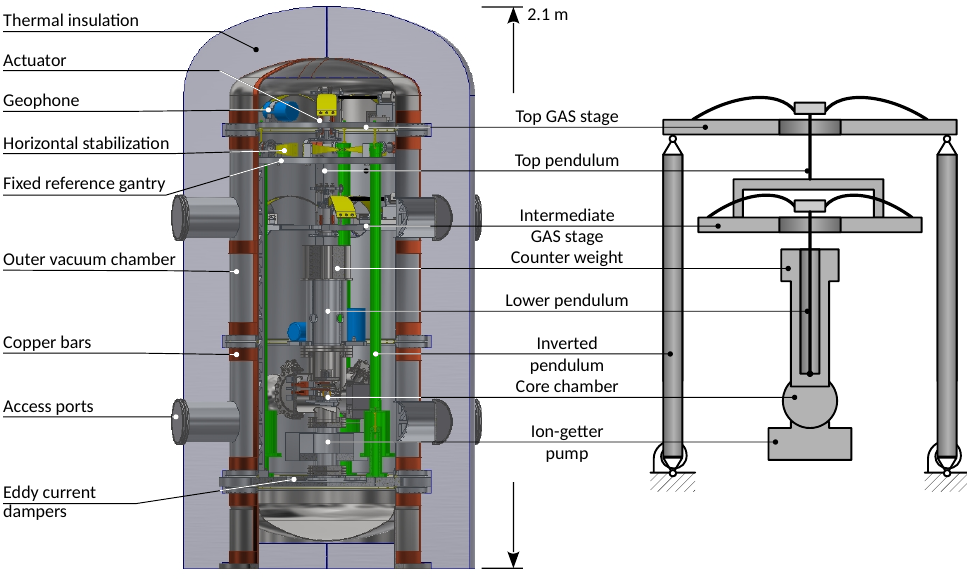
Figure 4. Overview of the C ANNEX setup. ( Left ) Two-staged working version of the seismic attenuation and thermal insulation system. ( Right ) Simplified